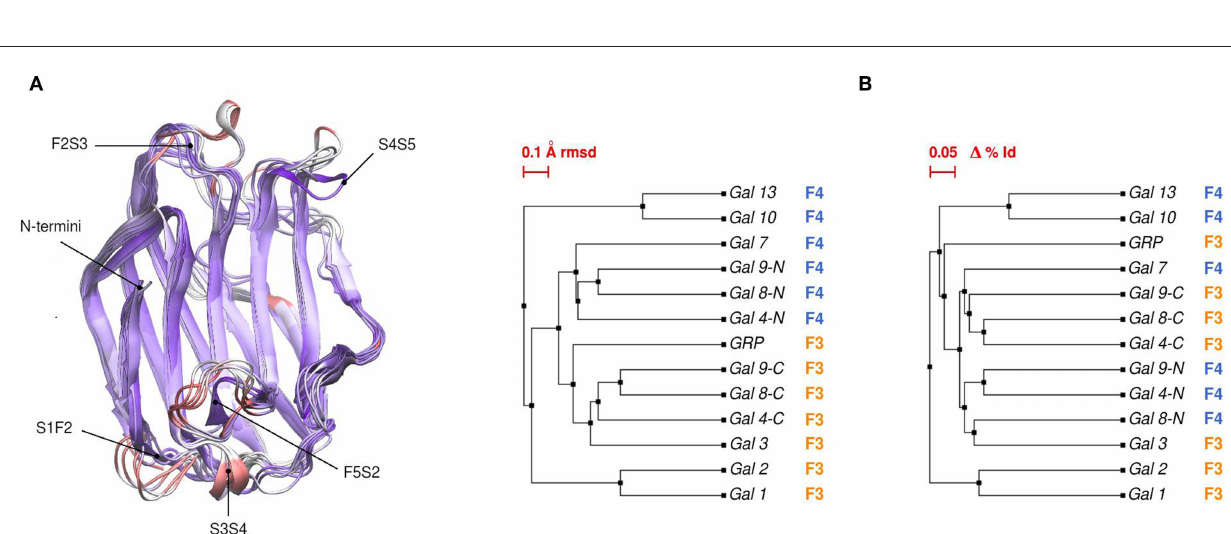
FIGURE 1 | Structure of a Galectin. (A) Gal-1 dimer. (B) Detail of the Gal-1 monomer differentiating the “S-sheet” (strands S1–S6) in yellow, and the “F-sheet” (strands F1–F5) in red. All cysteine side chains drawn as Balls and sticks.